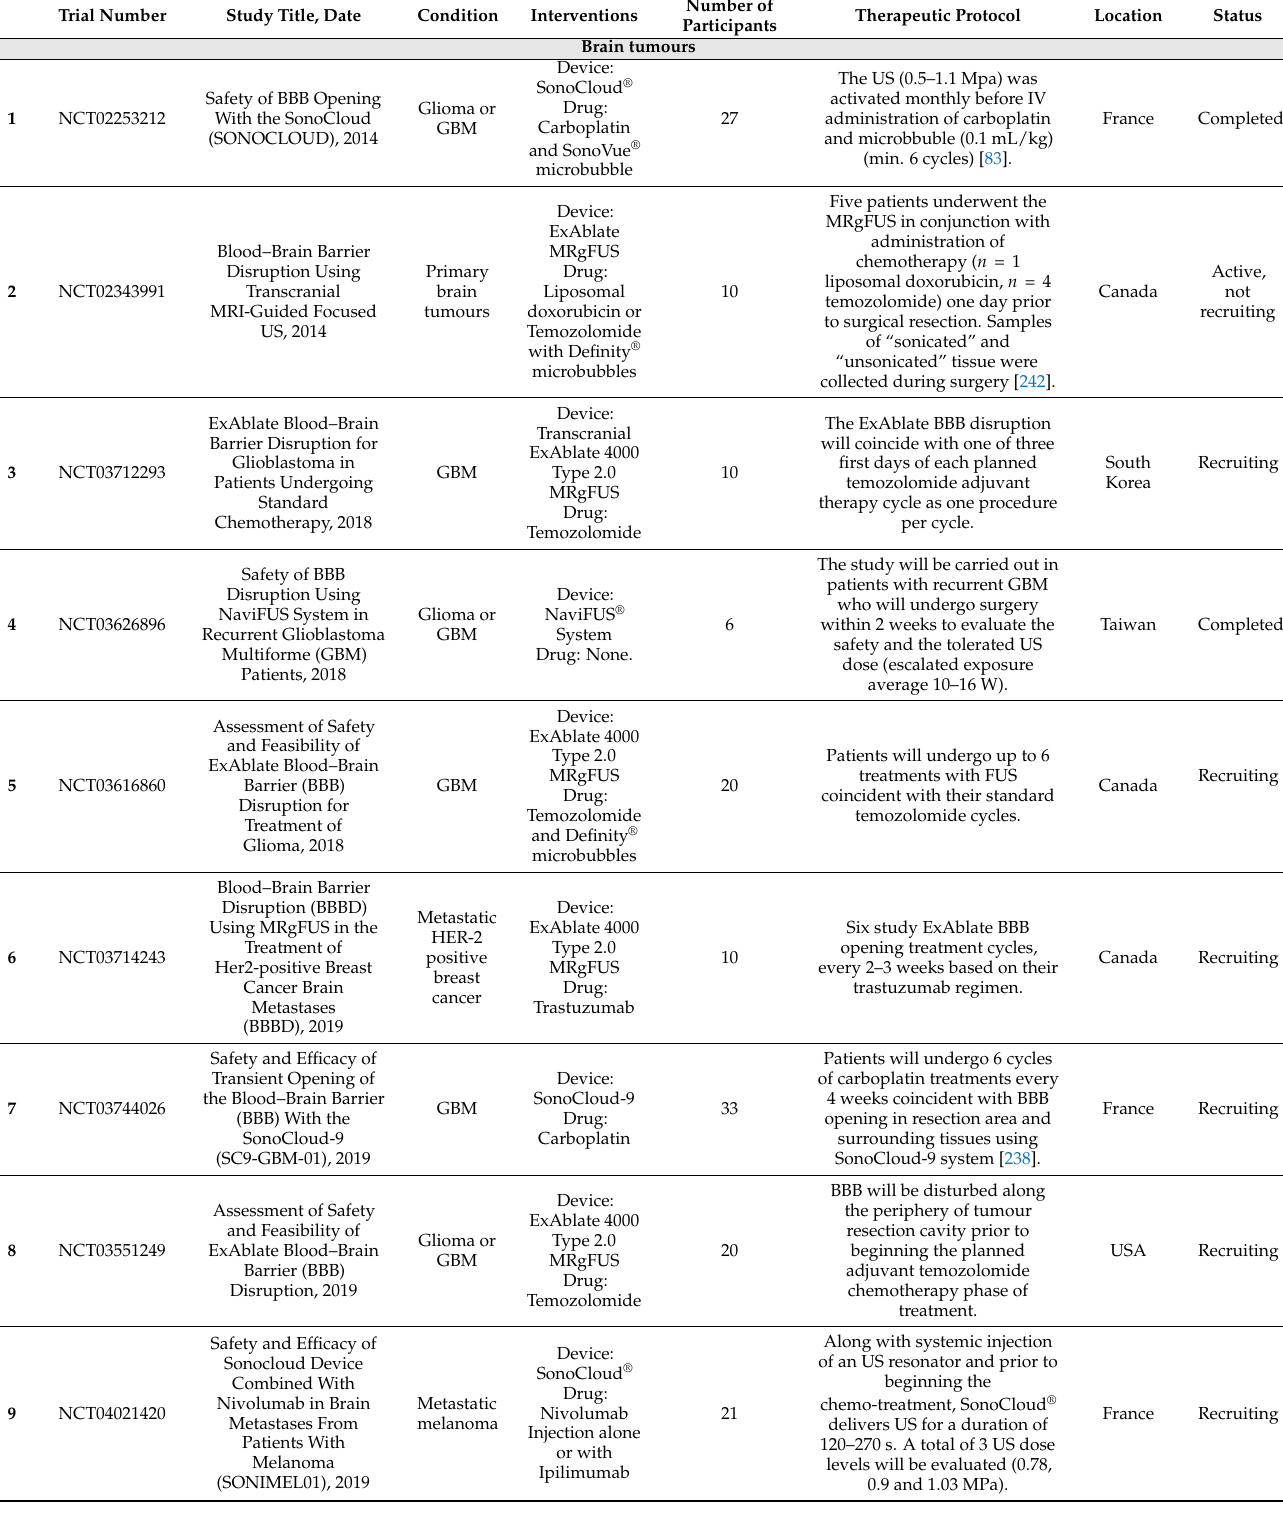
Table 1. A summary of clinical trials to date evaluating the effects of ultrasound-mediated blood– brain barrier opening in humans (ClinicalTrials.gov, 2021). GBM, Glioblastoma multiforme; MRgFUS, MR-guided Focused; US, ultrasound. Permission for adaptation from ref [211] granted under